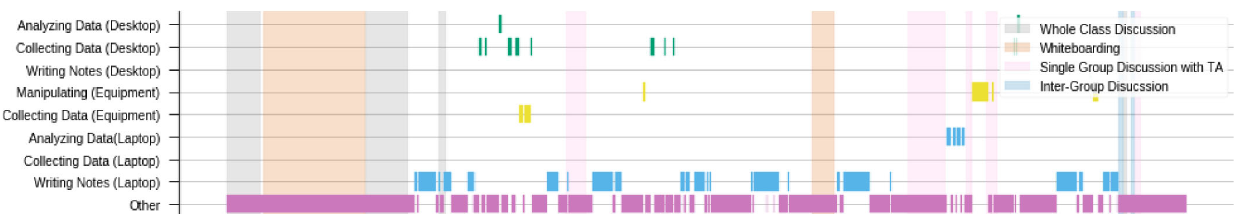
FIG. 5. Breakdown of codes by decomposing coarse behavior (e.g., “ handling laptop ” ) into more fine-grained behavior (e.g., “ analyzing data ” ). Ten videos were coded, resulting in 23 decomposed profiles from 17 different students (five students appeared in more than one video). (a) A breakdown of each code, showing the fraction of time students engaged in a particular task while coded as a particular behavior. Three of the five codes (desktop, equipment, and laptop) were directly decomposed into subcodes while analyzing videos, as shown in (b) illustrating a sample coded time series. Four additional “ group states ” were coded in the videos, representing large group behavior (discussing with a TA or UTA, conversing with other groups, whole class discussions and announcements, and using a whiteboard). We decomposed the other code by overlapping it with these larger group states. The paper code was purely represented by students filling out paper worksheets in the traditional